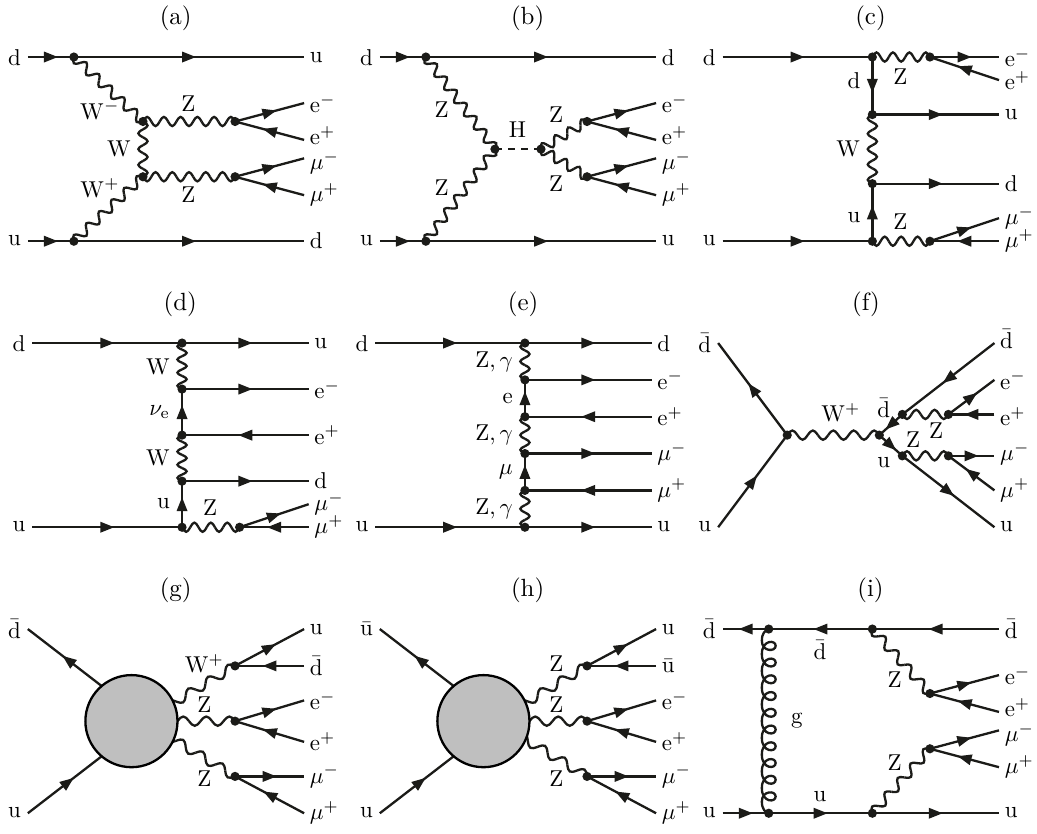
Figure 1. Examples of tree-level Feynman